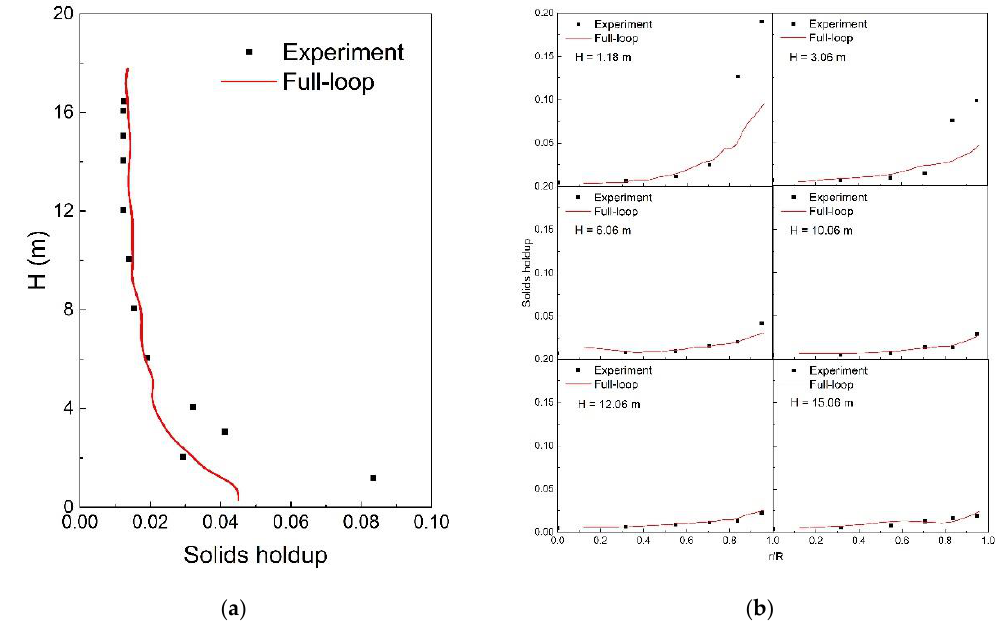
Figure 4. Comparison of time-averaged solids holdup profiles of the riser in the simulation and experiment at Gs = 100 kg m − 2 s − 1 . ( a ) Axial solids holdup distribution, ( b ) radial solids holdup distribution.